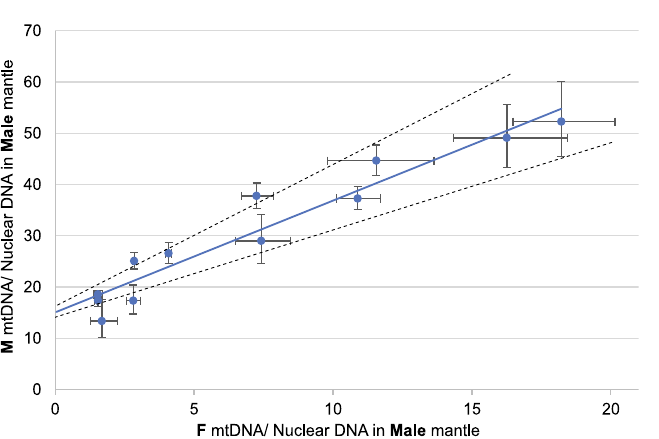
Figure 5. Ratios of M to F and F to M mitogenomes in tissues. A. F to M mtDNA ratio in Female mantle issues; B. M to F mtDNA ratio in Male mantle; * asterisks show samples where the M mtDNA copy number approaches zero, hence in those samples the F/M ratio lies between infinity and the marked value. All results were presented in logarithmic scale.